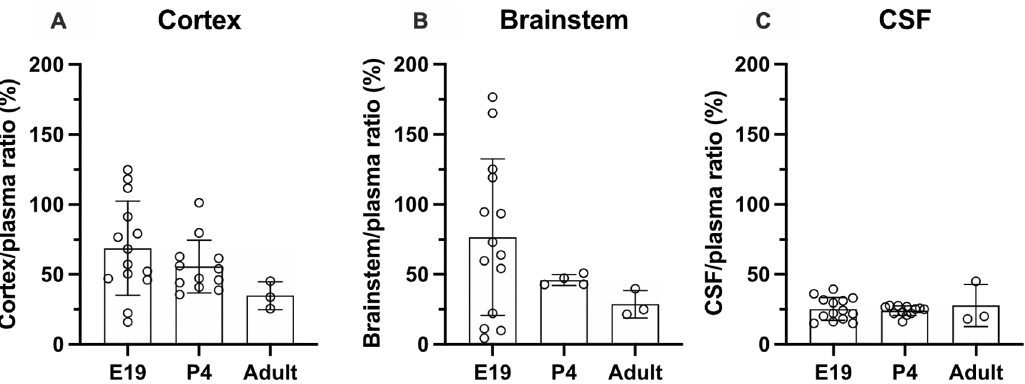
Figure3.Age-dependententryofolanzapineintotherat. (A)Braincortex(B)brainstemand(C)cerebrospinalfluid (CSF) at three ages: E19, P4 and adult, 30 min after a single intraperitoneal ( i.p. ) injection of 0.15 mg/kg olanzapine containing a radioactive tracer ([ 3 H]olanzapine). Bars are means (cid:3) SD. Note each point represents results from an individual animal (n=3 –